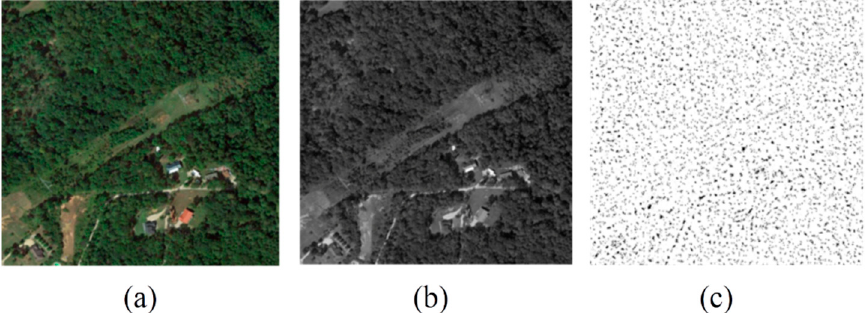
Figure 7. Local binary pattern (LBP) conversion process where ( a ) is the RGB satellite image, ( b ) is the gray level image, and ( c ) is the LBP image.